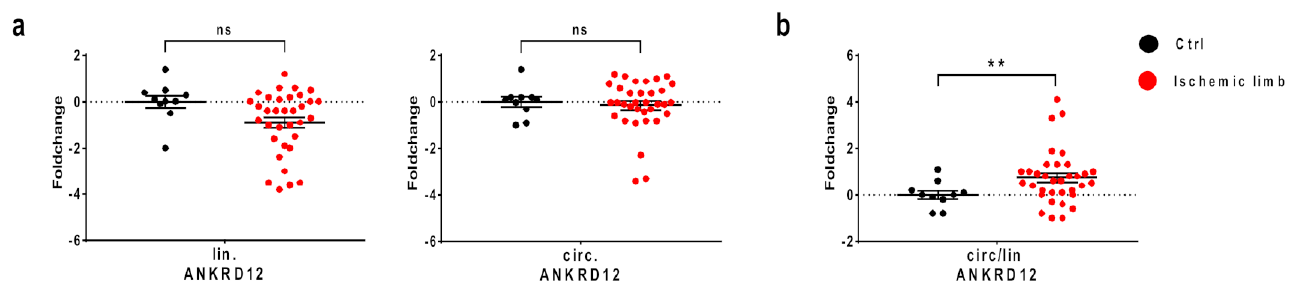
Figure 5. Increased ANKRD12 circular-to-linear ratio in ischemic muscles of CLI patients. ( a ) Ex- pression levels of linear and circular ANKRD12 RNAs were measured by qPCR in skeletal muscle samples taken from the ischemic limb of CLI patients ( n = 34) and compared to non-ischemic muscles of control subjects ( n = 10). ( b ) circular-to-linear ratios (circ/lin) were determined. Fold changes are in log2 scale ( − ∆∆ CT) and individual values are indicated by dots, while mean and SEM are indicated by horizontal lines (** p < 0.01; ns: not